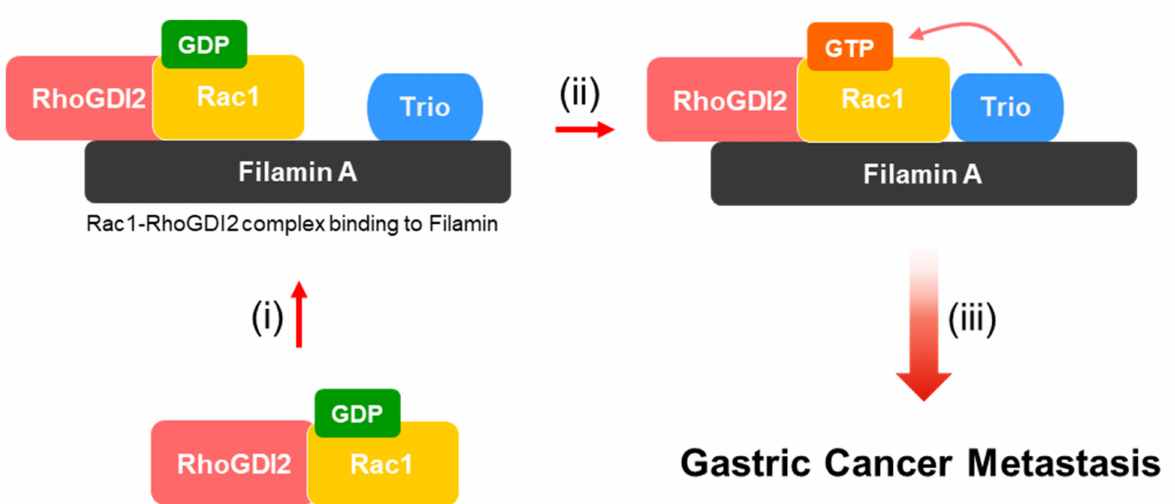
Figure 6. Proposed model to illustrate how activation of Rac1 by RhoGDI2 may lead to gastric cancer metastasis. (i) Interaction between RhoGDI2 and Rac1 is a prerequisite for the recruitment of Rac1 to Filamin A. (ii) Filamin A could play as a scaffold protein that mediates Rac1 activation. (iii) Activated Rac1 by Trio might enhance gastric cancer metastasis.